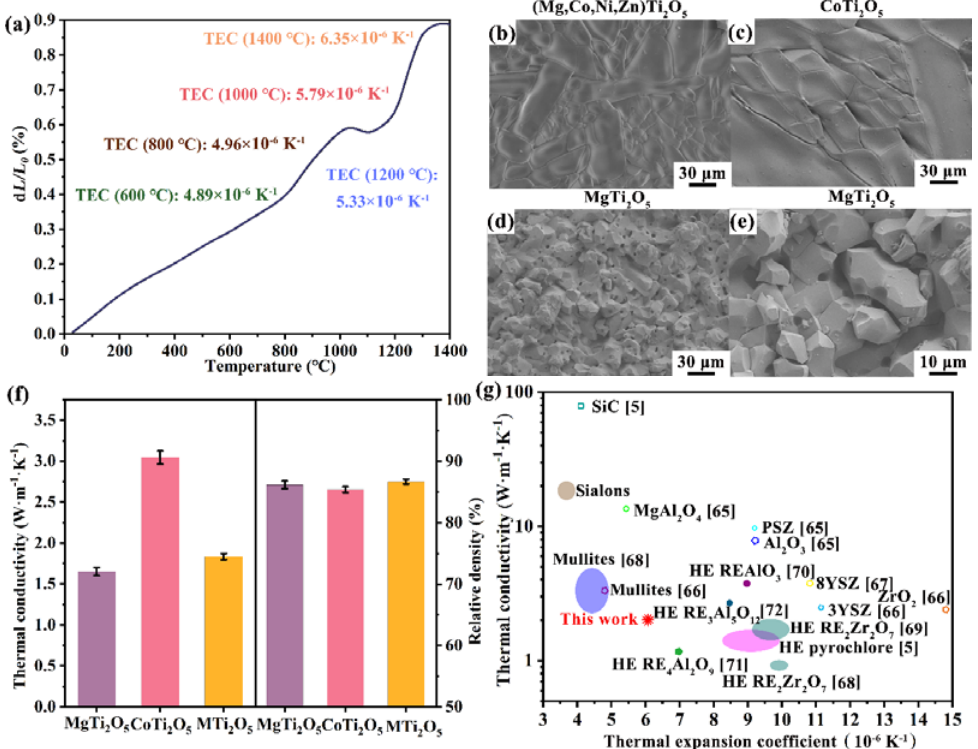
Fig. 14 (a) Thermal expansion curve and thermal expansion coefficients of high-entropy (Mg,Co,Ni,Zn)Ti 2 O 5 . (b–e) SEM images and (f) relative densities and thermal conductivities of high-entropy (Mg,Co,Ni,Zn)Ti 2 O 5 , CoTi 2 O 5 , and MgTi 2 O 5 . (g) Thermal conductivity vs. thermal expansion